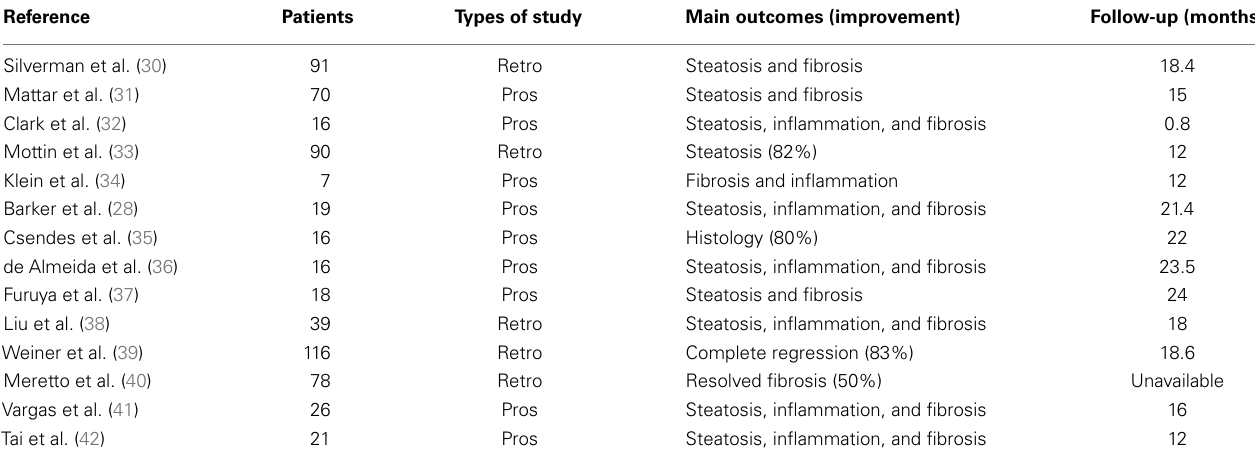
Table 1 | Effect of RYGB on NAFLD .